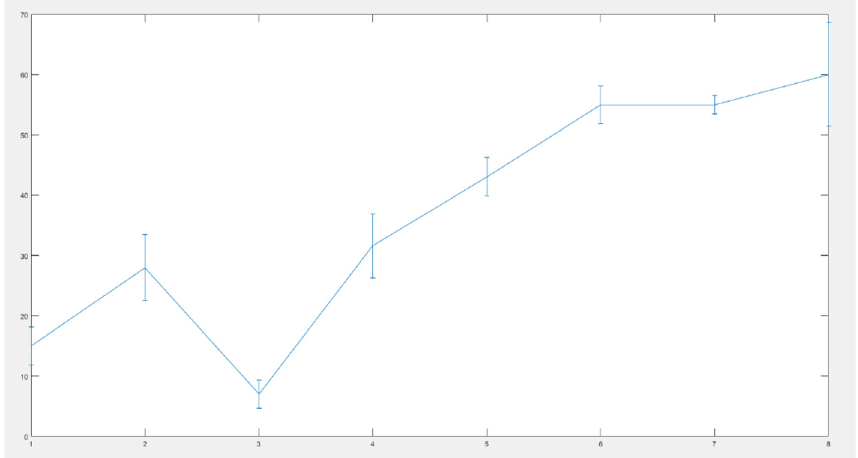
Figure 14. Difference between the two diagnoses: error bar graph.